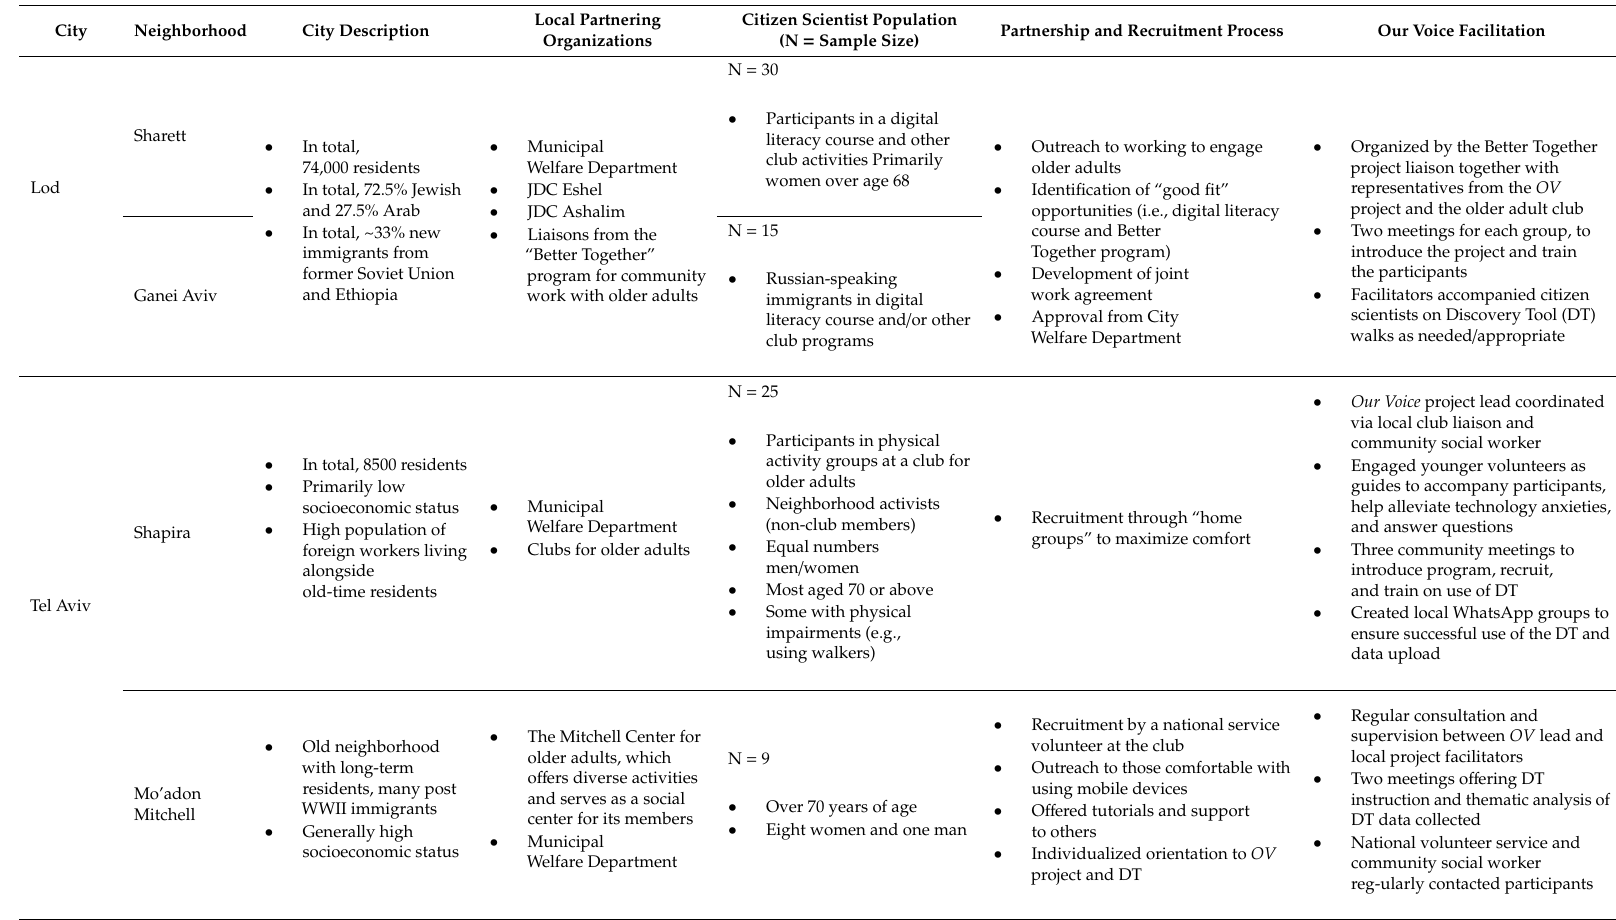
Table 2. Descriptive information on implementation of Israel’s Our Voice projects in five additional